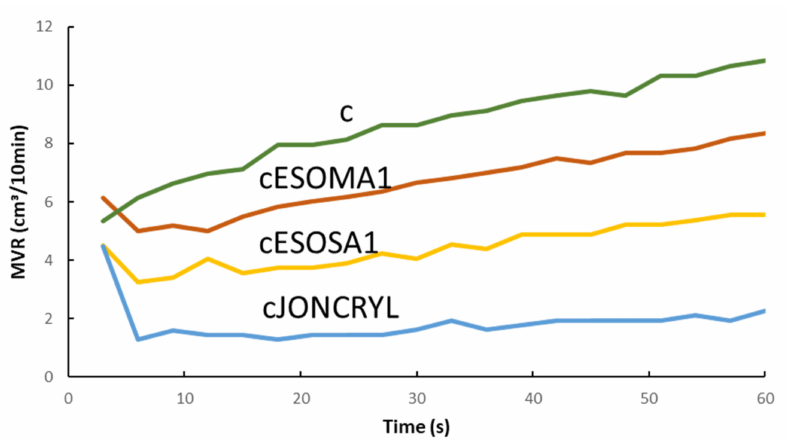
Figure 8. Comparison of MVR trends between the bran composite (c) and the composite chain extended with ESO + MA (cESOMA1), ESO + SA (cESOSA1) or Joncryl